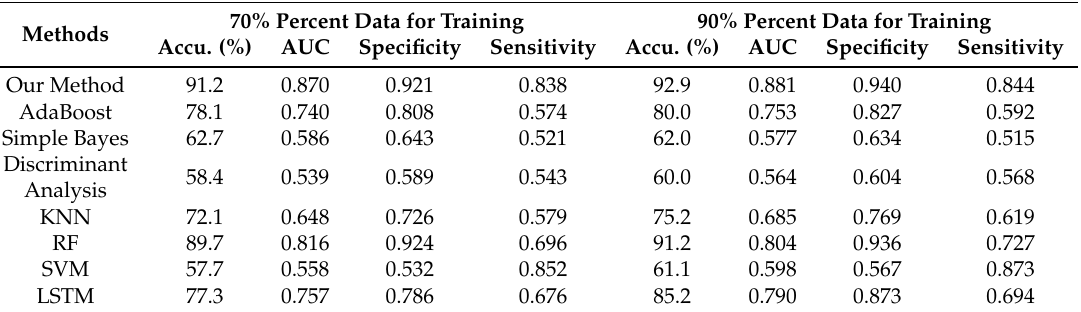
Table 7. The comparison among eight methods on our real-world dataset without the proposed feature extraction method. In terms of classification accuracy or AUC, our boosting method outperforms the other state-of-the-art methods in all cases.